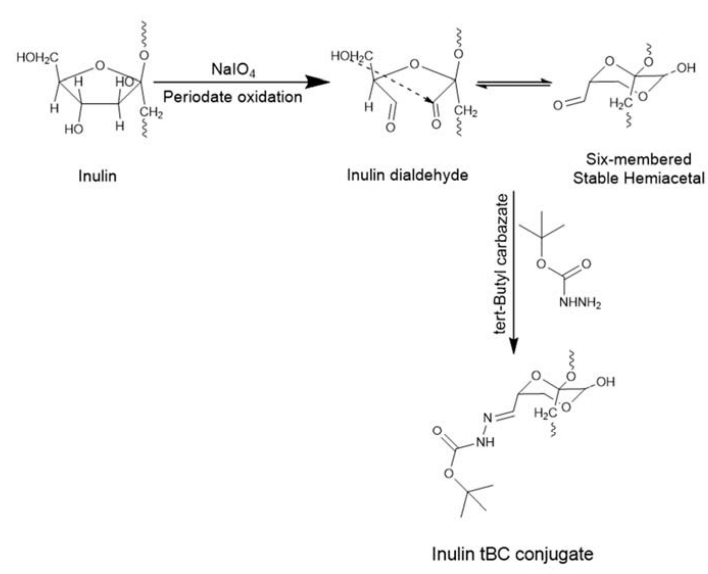
Scheme 2. Showing the reaction between oxidized inulin and tBC. Polymers 2020 , 12 , x FOR PEER REVIEW